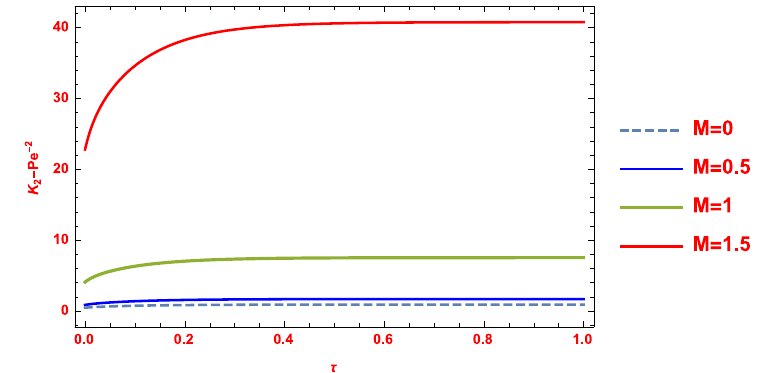
Figure 2. K 2 − Pe − 2 varying along τ for different M